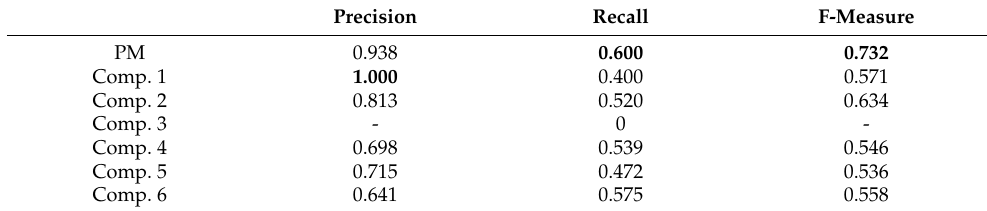
Table 6. Stop detection accuracy of each